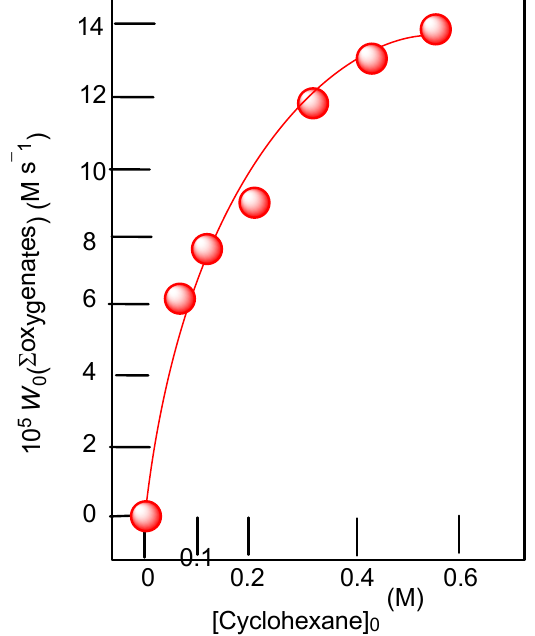
Figure 9. Dependence of the initial rate of oxygenate (sum cyclohexanol + cyclohexanone) formation W 0 for complex 4 on the initial concentration of cyclohexane (Initial concentrations: Catalyst 5 × 10 − 4 M, H 2 O 2 1.5 M, HNO 3 0.05 M, CH 3 CN up to 2.5 mL, T = 50 ◦ C).